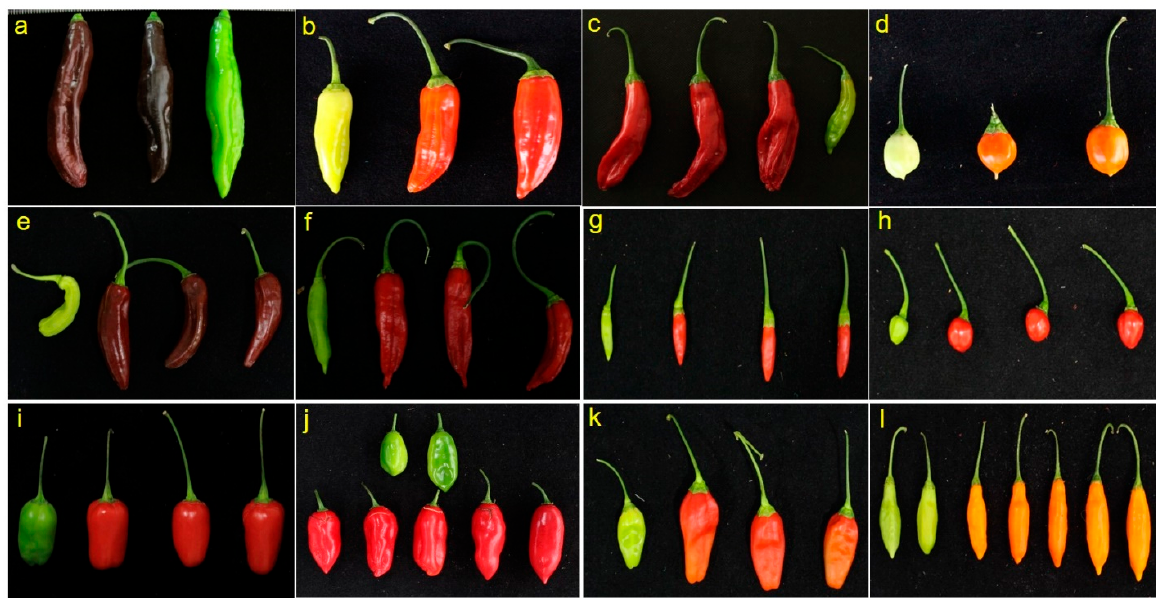
Figure 5. Fruit characteristics of anthracnose resistant pepper genetic resources selected for the inoculation study. ( a ) C. chinense ; ( b ) C. baccatum var. pendulum ; ( c ) C. baccatum var. baccatum ; ( d ) C. baccatum var. baccatum ; ( e ) C. chinense ; ( f ) C. baccatum ; ( g ) C. baccatum ; ( h ) C. chinense ; ( i ) C. frutescens ; ( j ) C. chinense ; ( k ) C. chinense ; ( l ) C. baccatum